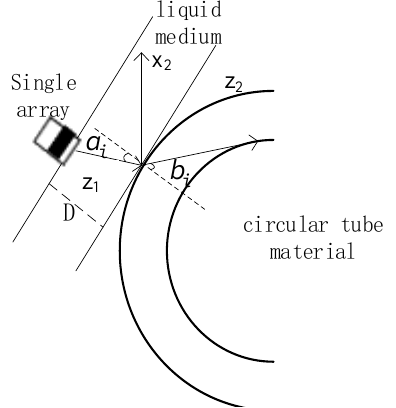
a is the i a is the i b is the refraction angle of the i b is the refraction angle of the i